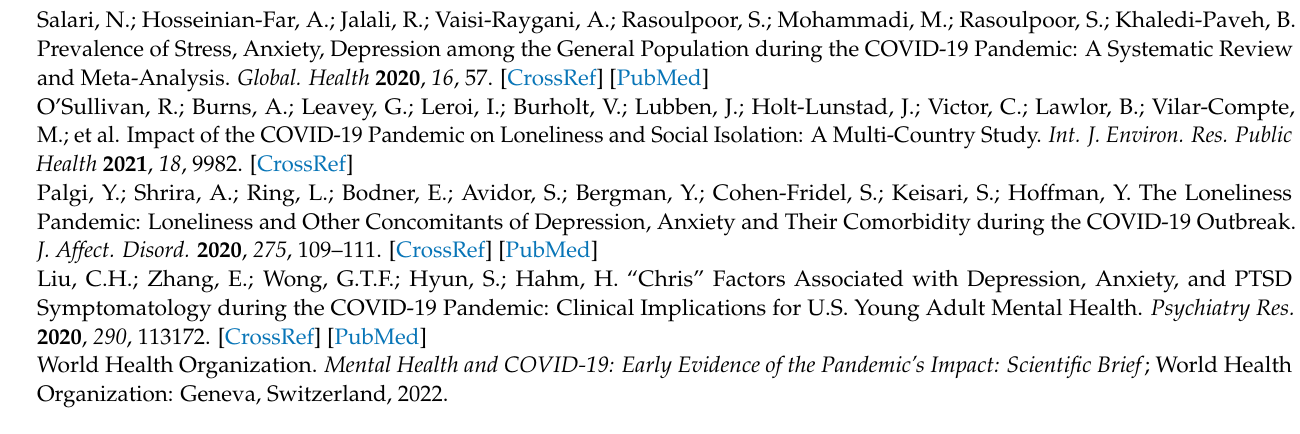
Table S1: Overview of the search terms used in each database; Supplementary Material File S2: Adapted version of the Newcastle Ottawa Scale